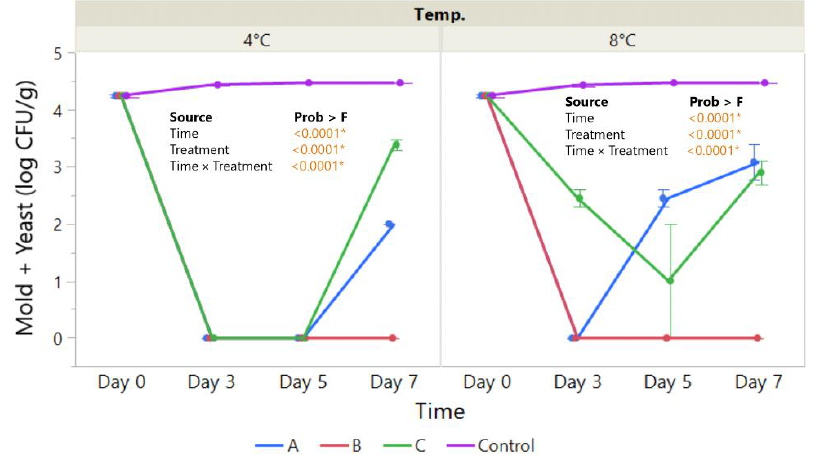
Figure 7. The effect of coating treatment on total number of strawberry mold and yeast colonies (log CFU/g) for a 10 −2 dilution during a 7-day storage period at 4 °C and 8 °C. The p -values for the effects of Treatment (coating), Time and Interaction Treatment × Time are shown. Data are means ± SEM (n = 2). Asterisk (*) indicates significance ( p < 0.05*).